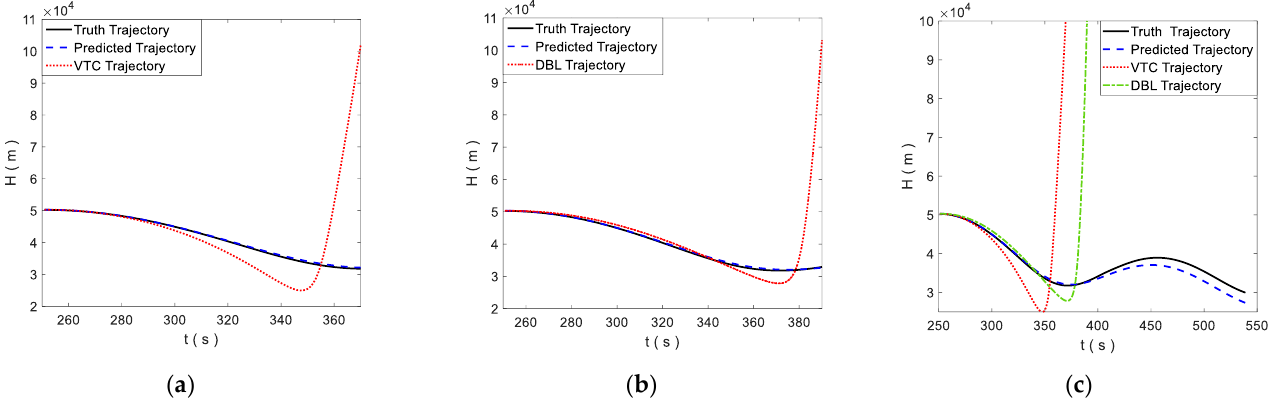
Figure 21. Comparison of longitudinal prediction effect among different methods: (a) is the longitudinal prediction effect of VTC method; (b) is the longitudinal prediction effect of DBL method; and (c) is the long-term longitudinal prediction effect.